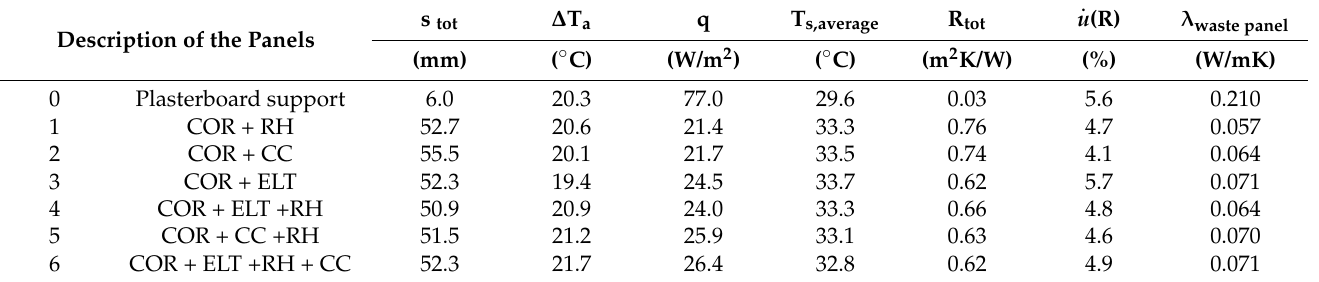
Table 4. Thermal conductivity of the recycled mixed panels and related measured parameters. Description of the